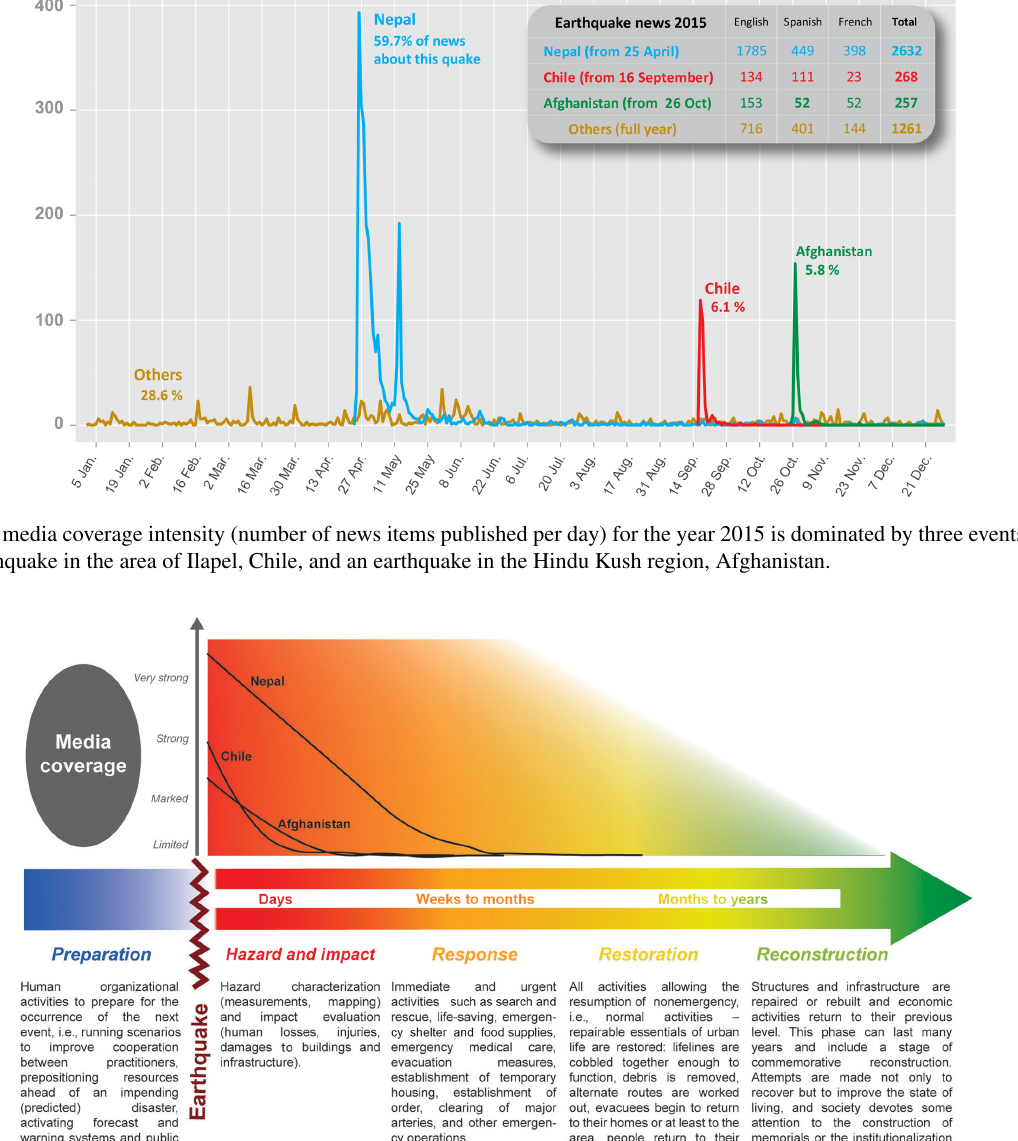
Imagine that an important earthquake